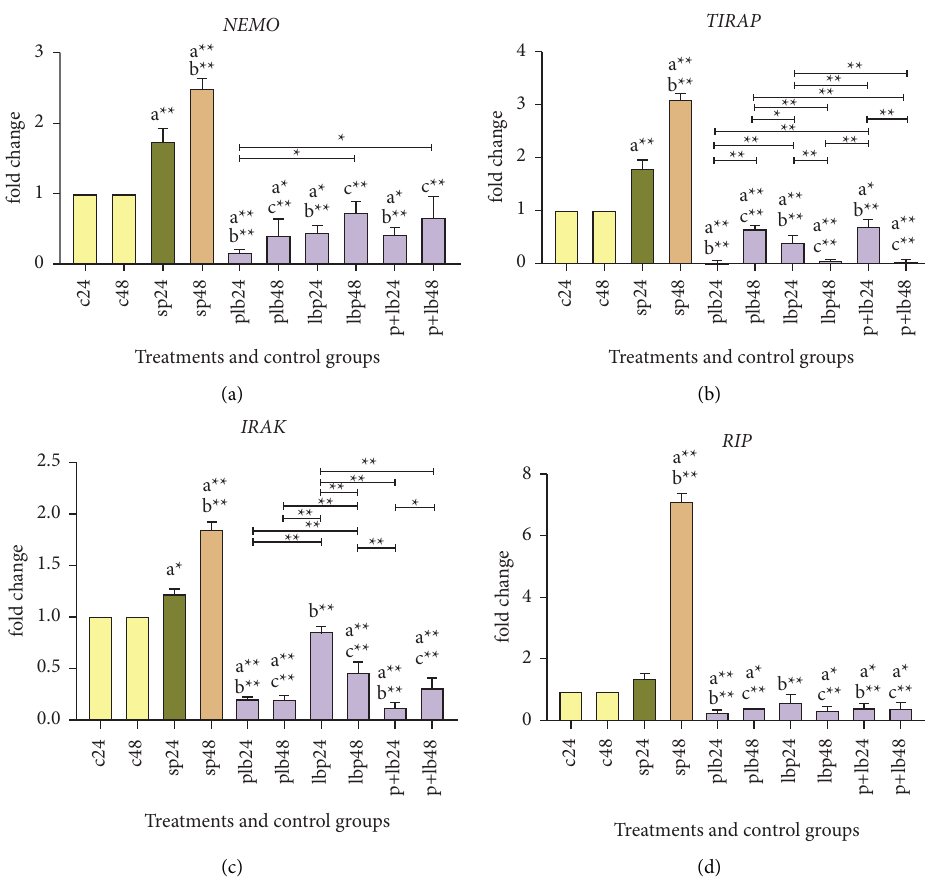
Figure 3: Relative gene expression (mean fold change) of (a) NEMO , (b) TIRAP , (c) IRAK , (d) RIP in the diferent groups of treatments. Data were normalized with GAPDH . Data were represented as mean SD. Te number 24 and 48 refers to diferent time orders of HT-29cell line treatments. (C) represents control; (P) represents pathogen; PLB represents frst pathogen and then Lactobacillus/Bifdobacterium ; LBP represents frst Lactobacillus/Bifdobacterium and then sonicated pathogen; P +LB, sonicated pathogen and then Lactobacillus/Bifdo- bacterium added simultaneously. Data were considered statistically signifcant when p < 0 . 05 ( ∗ p < 0 . 05, ∗∗ p < 0 . 001). Letter (a) indicates the relatedness between C24 and C48 with other treatments, letter (b) shows the relatedness between sp24 and other treatments, and letter (c) shows the relatedness between sp48 with other treatments. Te relatedness between other treatments is shown with